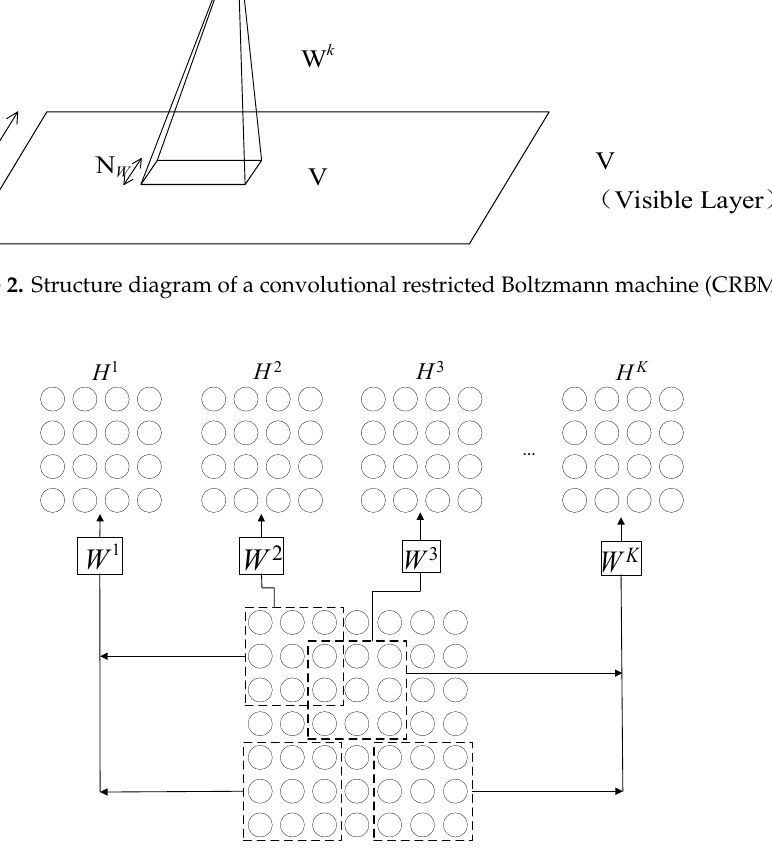
Figure 3. The process of obtaining hidden layers from the visible layer based on CRBM.